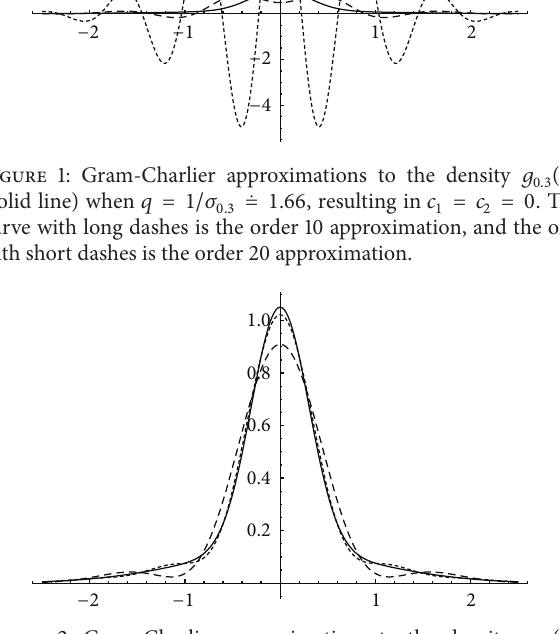
Figure 2: Gram-Charlier approximations to the density 𝑔 0.3 (𝑥) (solid line) when 𝑞 = 1.4 . The curve with long dashes is the order 10 approximation, and the one with short dashes is the order 20